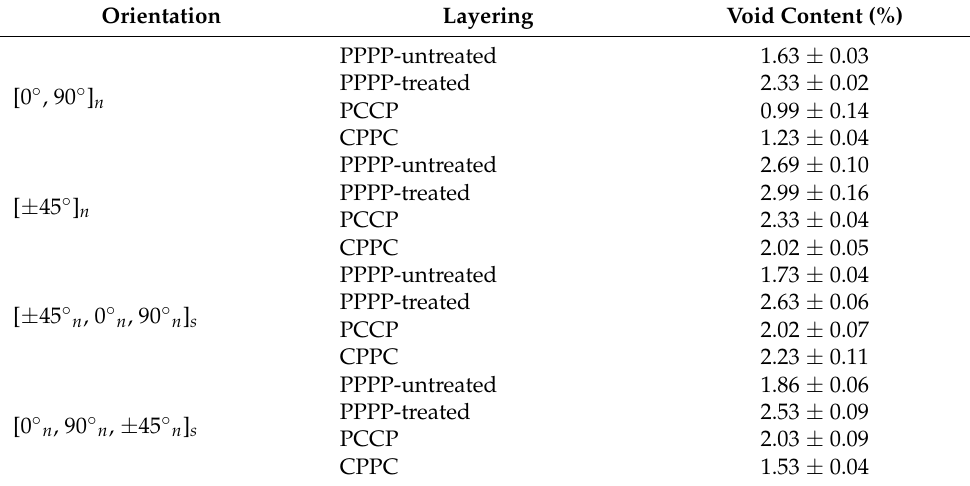
Table 3. Void contents of the